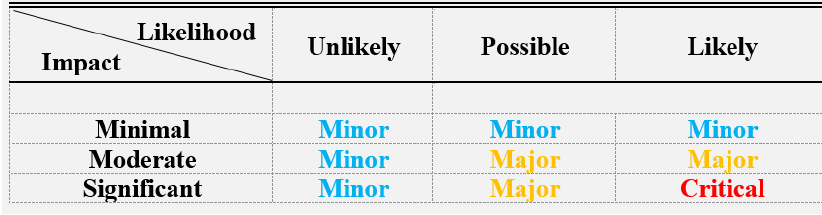
Figure 5. Risk assessment